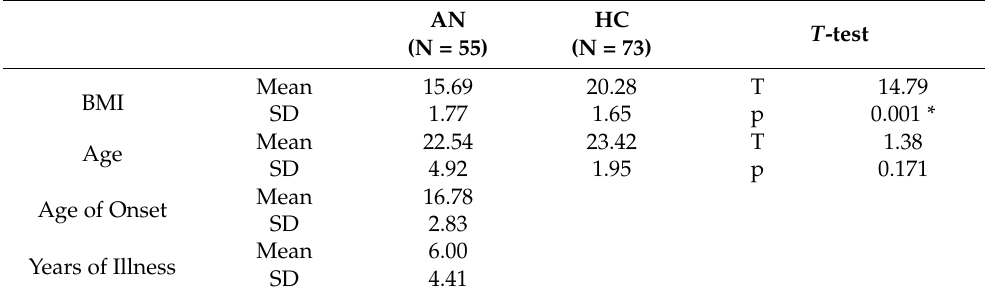
Table 1. Clinical